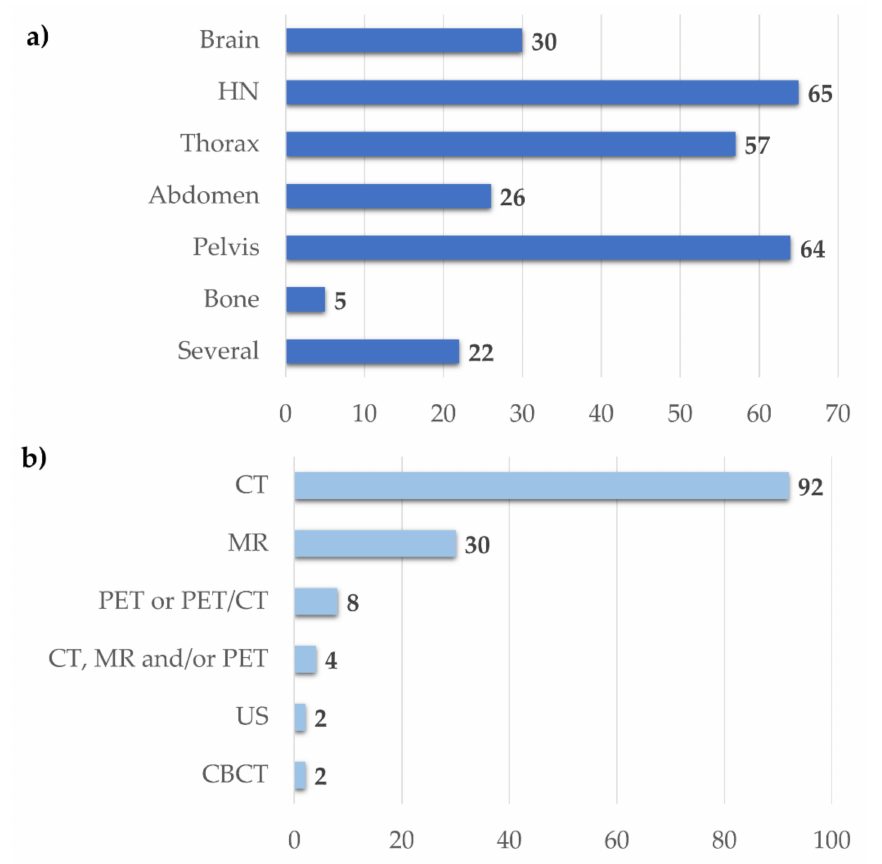
Figure 5. Numbers of identified papers in image segmentation according to ( a ) the contoured district using ML or DL methods, and ( b ) the imaging modality used for segmentation by adopting the convolutional neural network (CNN)